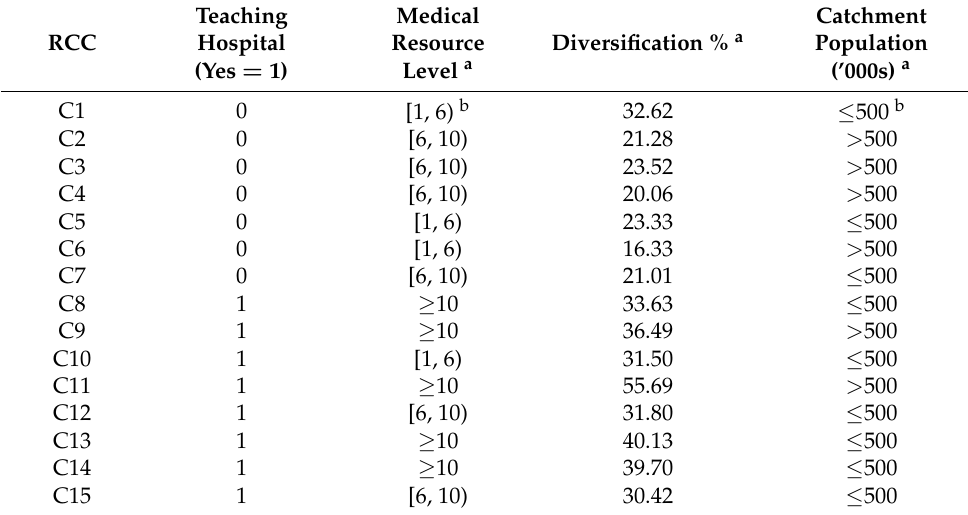
Table 1. Characteristics of regional cancer centers in